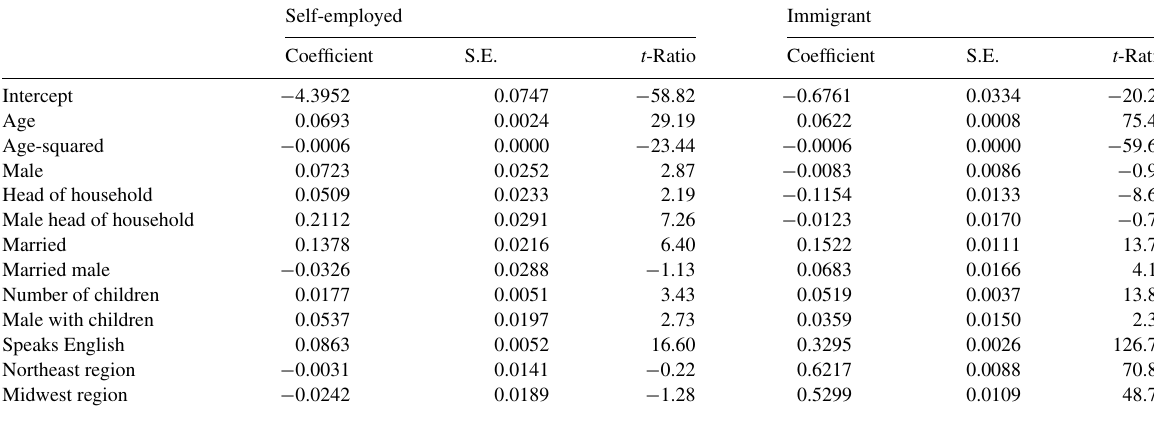
Table 10 Coefficient estimates from the bivariate probit model—Asian